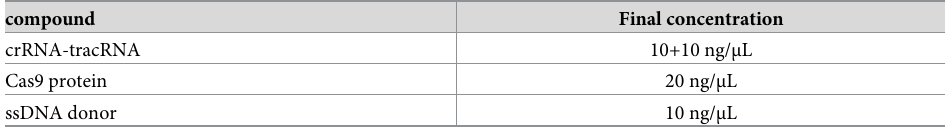
Table 1. Injection mixture for pronuclear